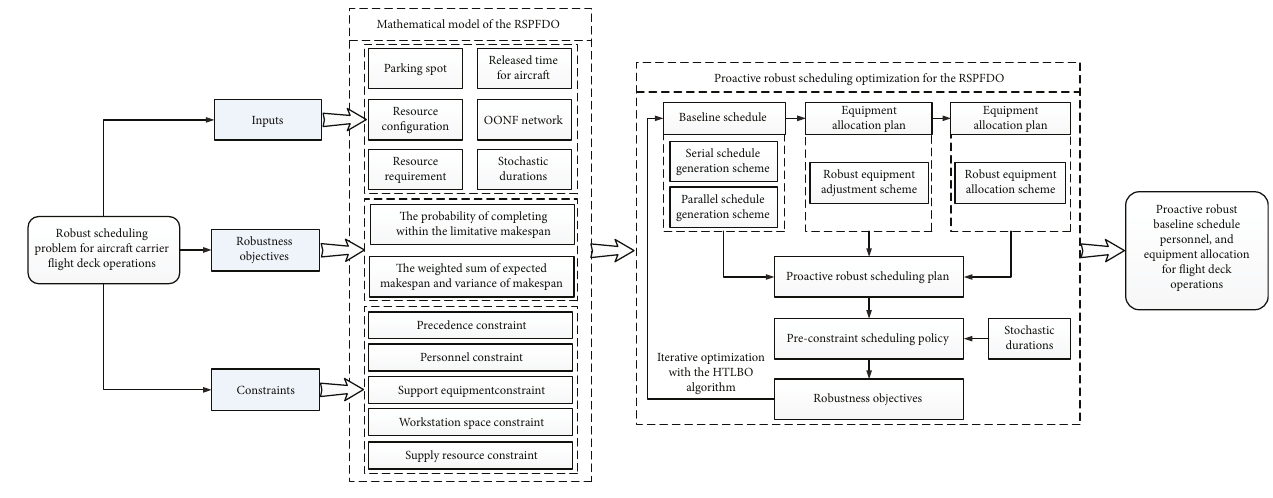
Figure 4: The framework for solving the RSPFDO. Table 1: Parameter de fi nition in the mathematical